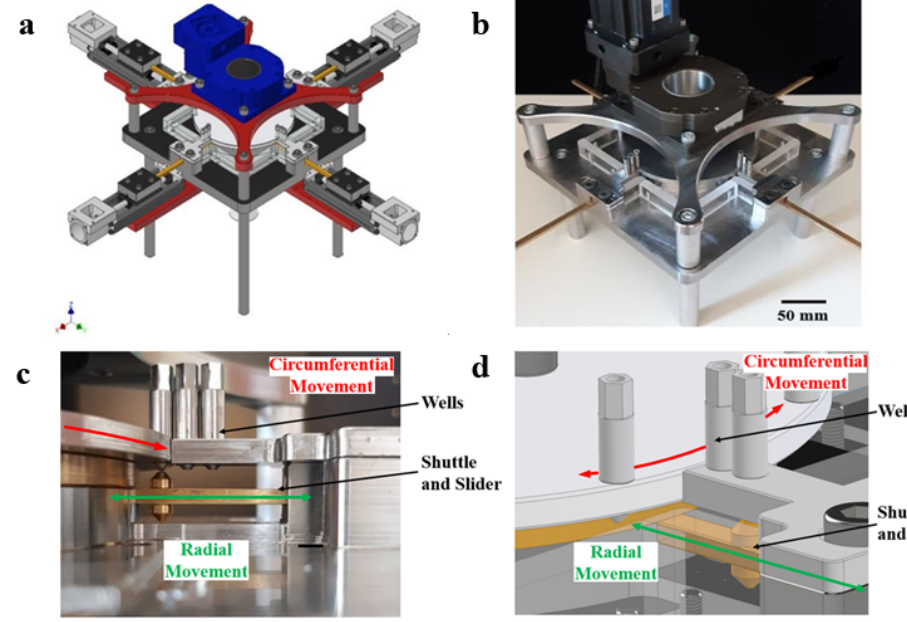
Figure 1. Prototype [22]. ( a ) CAD image of prototype. ( b ) Four-by-two prototype. ( c ) Circumferential movement of the ring is denoted by the red arrow and radial movement of the shuttle by the green arrow. ( d ) Corresponding CAD image.